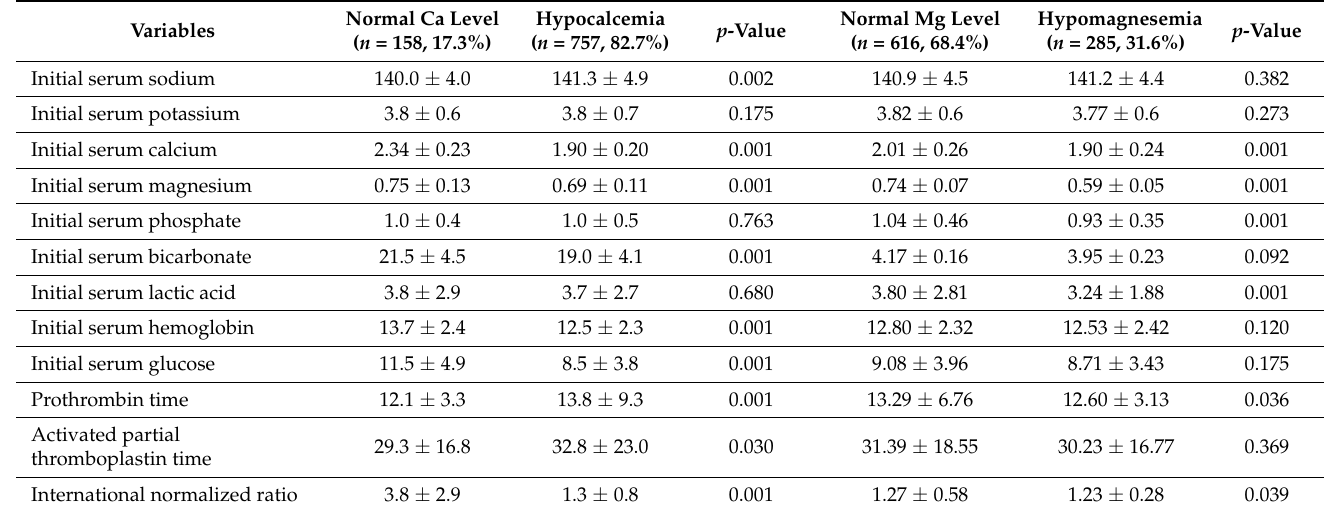
Table 5. Laboratory findings at admission in patients with traumatic brain